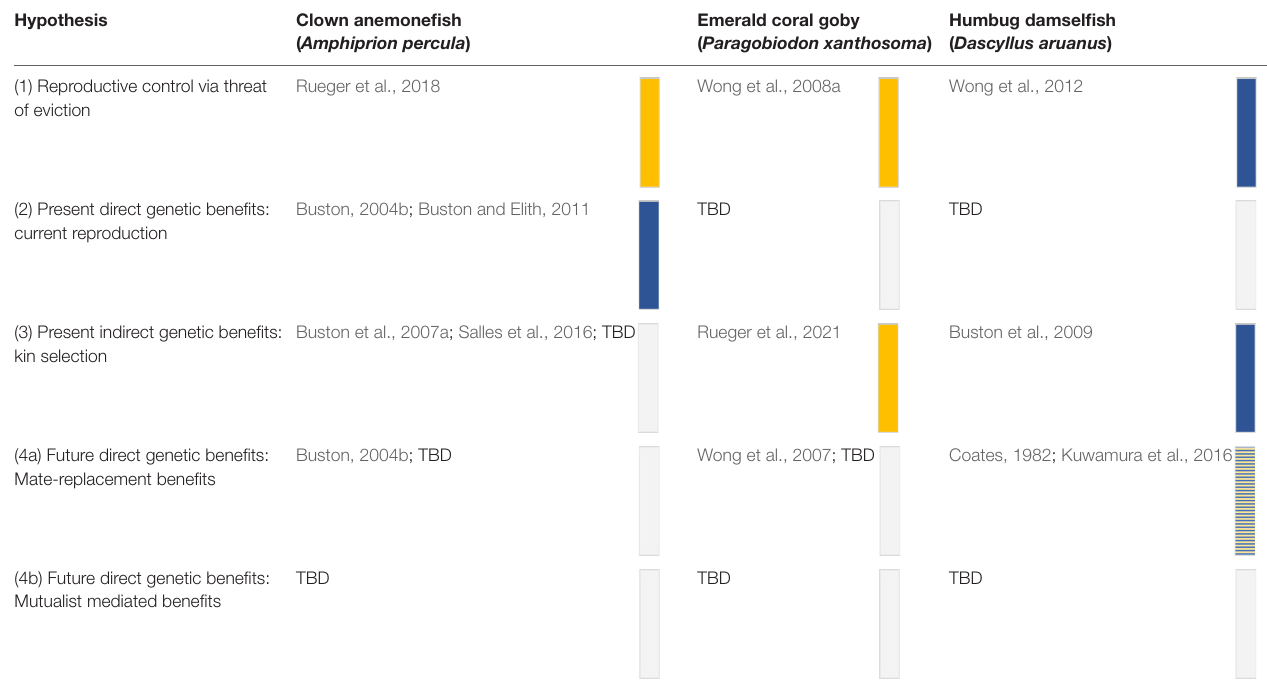
TABLE 2 | Major hypotheses for why breeders tolerate non-breeders in their territories in three tractable systems within coral reefs: the clown anemonefish, the emerald coral goby and the Humbug damselfish.